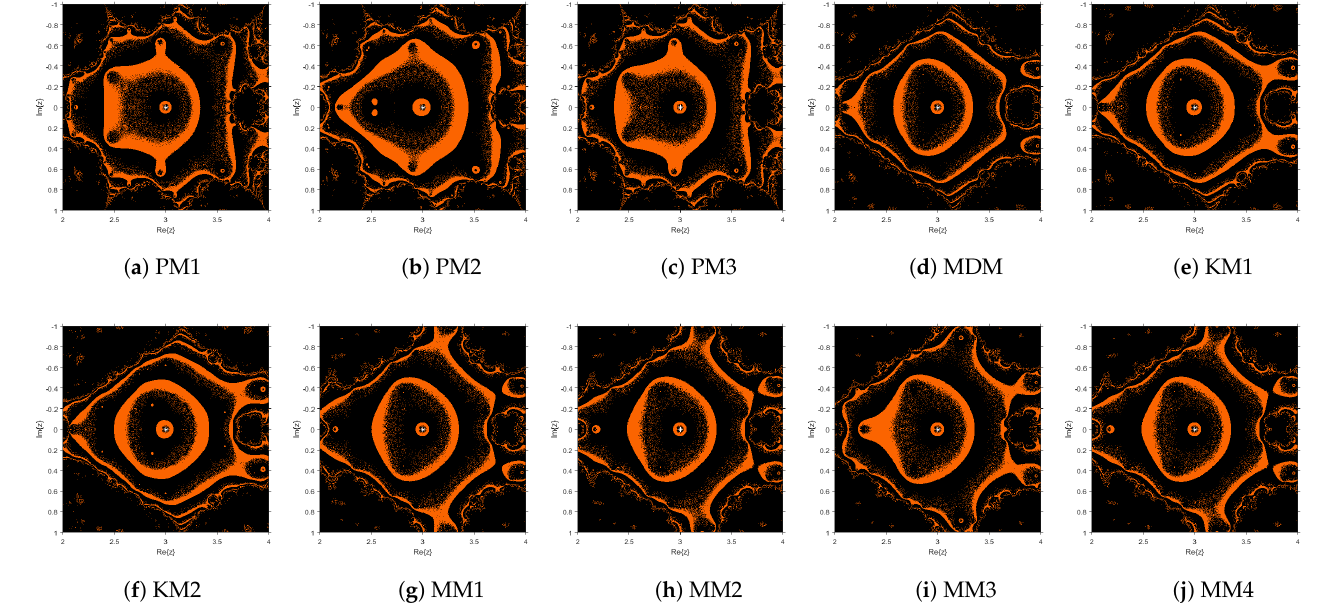
Figure 1. Basins of attraction of new and existing methods for Example